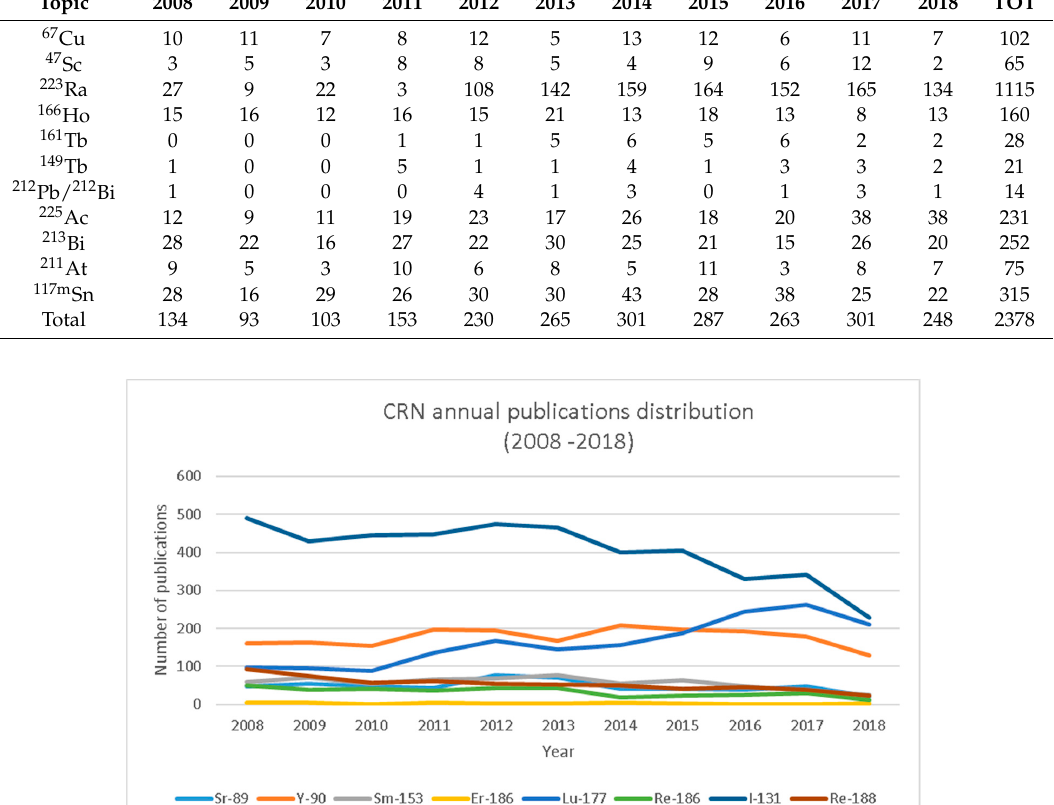
Figure 2. Graphical representation of the annual publications discussing CRNs (2008–2018).